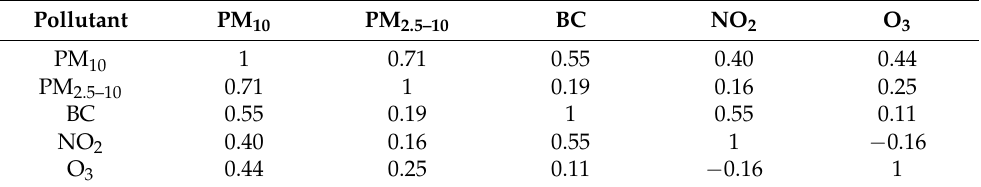
Table A5. Correlation matrix with R-values (Pearson correlation coefficients) between the different air pollutants measured in Stockholm during summertime (June, July and August) during the period